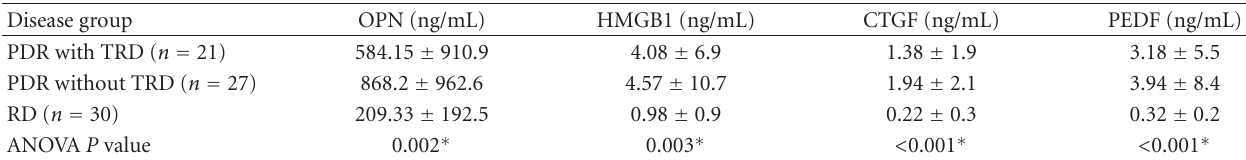
Table 3: Comparisons of mean angiogenesis and fibrogenesis regulatory factor levels in proliferative diabetic retinopathy (PDR) patients with or without traction retinal detachment (TRD).